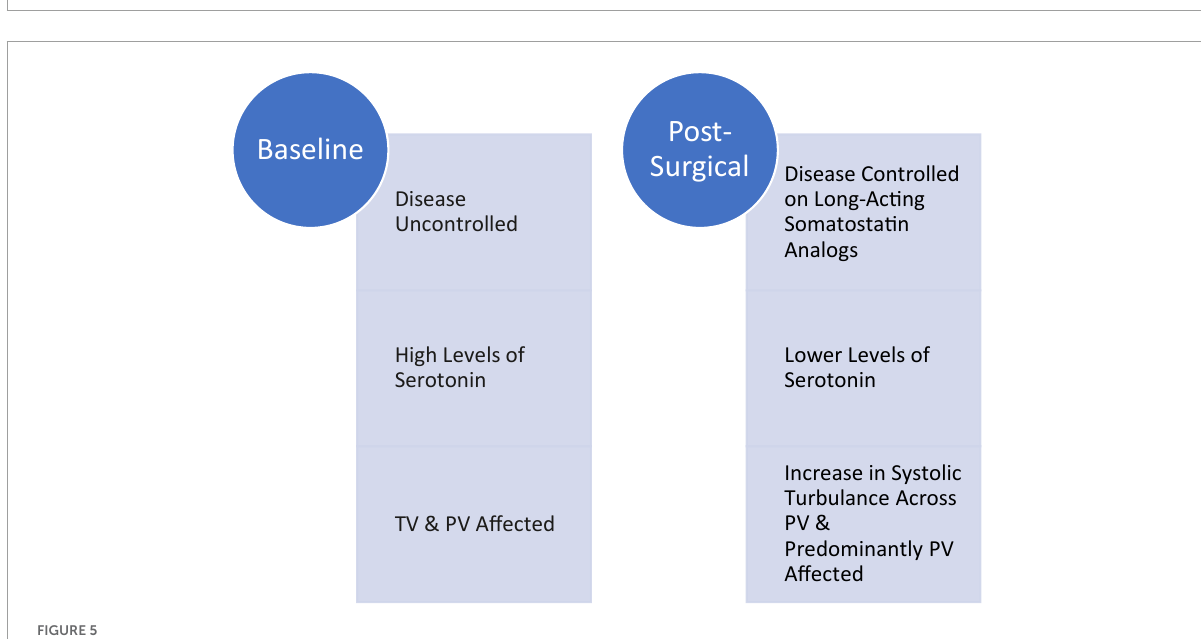
FIGURE5 Baseline symptomatic carcinoid heart disease (CnHD) versus post-surgical